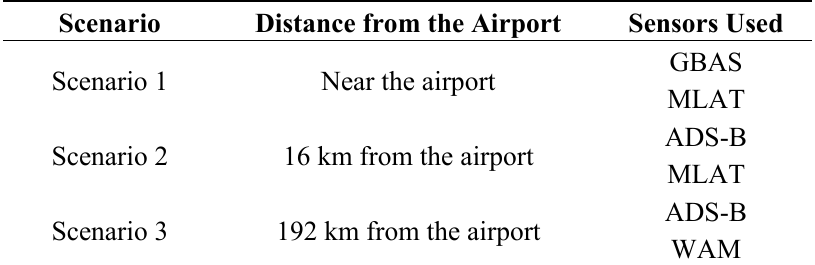
Table 1. Simulation